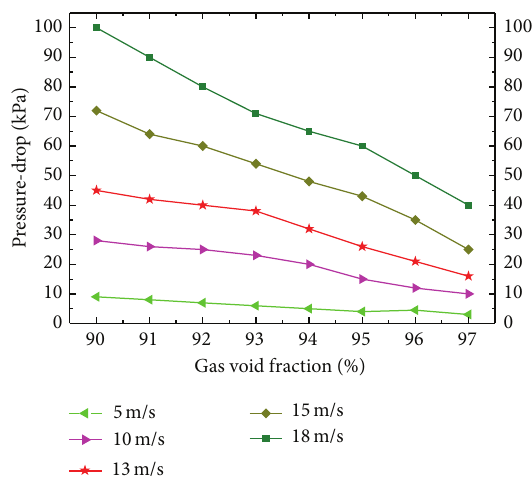
Figure 11: The influence of inlet velocity on pressure-drop.